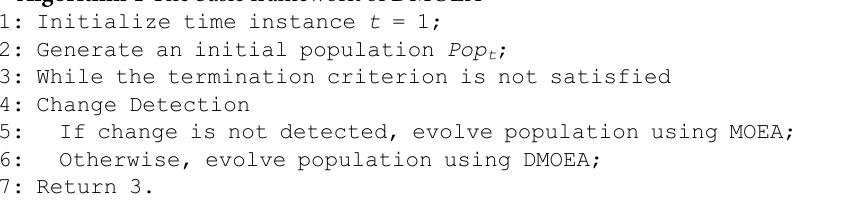
Algorithm 1 The basic framework of